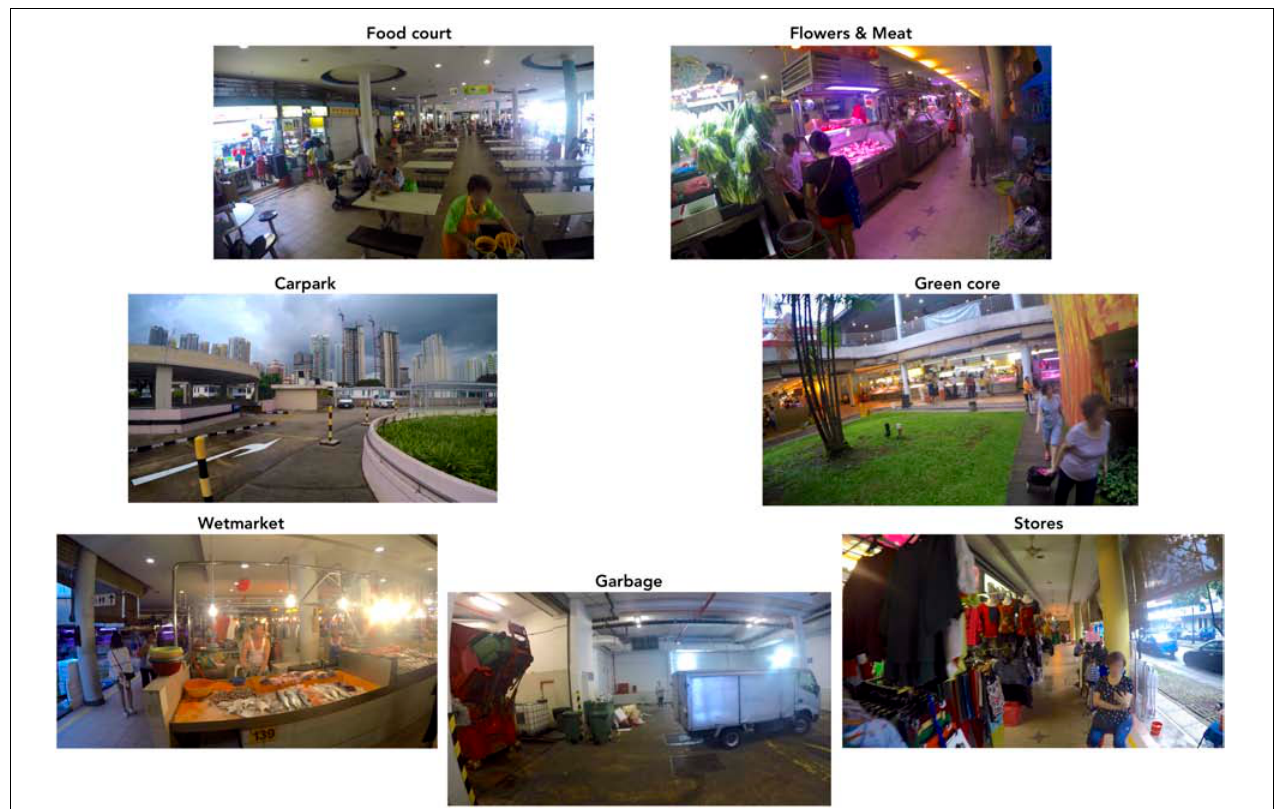
FIGURE 1 | Photos of the seven chosen locations at Tiong Bahru